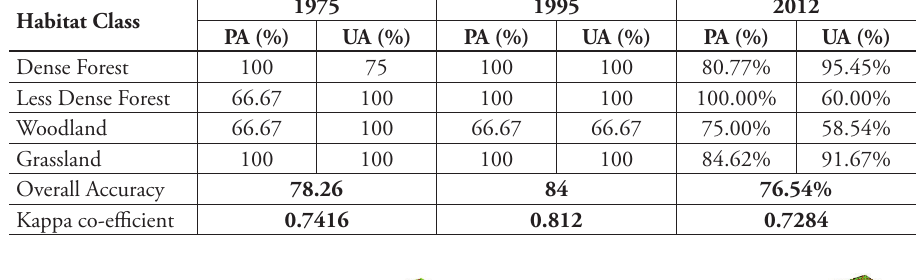
Table 2. Accuracy assessment tests (Producer’s Accuracy - PA), User’s Accuracy - UA).